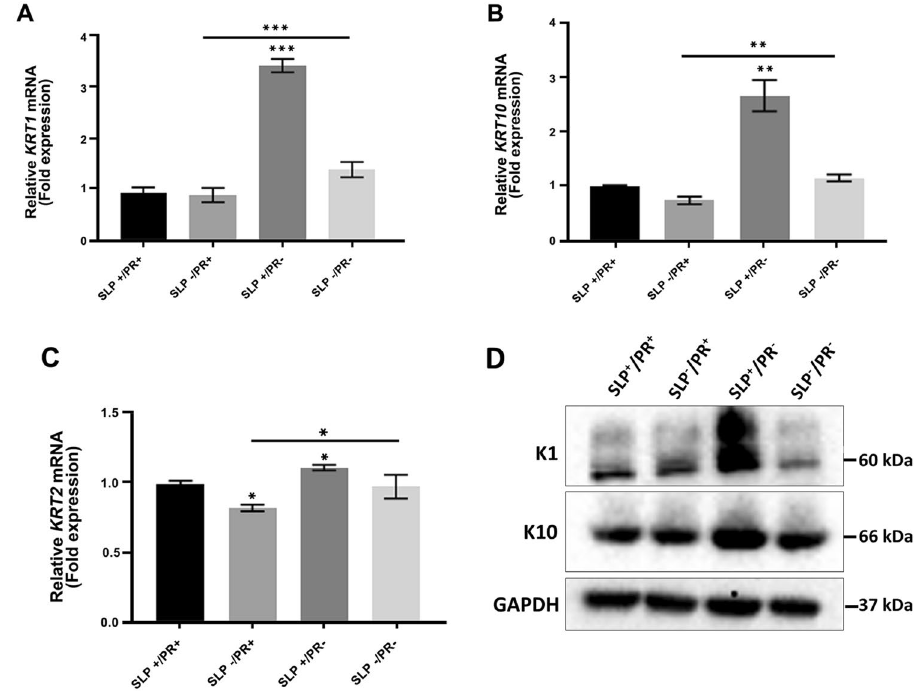
Figure 4. Influence of SLP and PR on mRNA and protein expression of K1, K10 and K2 in N/TERT-1 cells. N/ TERT-1 (200,000 cells) were grown in 2 ml growth medium per well of a 12 well plate for 3 days in four different RM + media conditions (SLP + /PR + , SLP − /PR + SLP + /PR − , SLP − /PR − ) in triplicates for each growth condition. Lysates were collected and analysed for mRNA using qPCR. The mRNA expression data are shown for ( A ) KRT1 , ( B ) KRT10 and ( C ) KRT2 as fold expression normalised to the expression of two housekeeping genes, POLR2A and YAP1 under different growth conditions. ( D ) N/TERT-1 (500,000 cells) were grown in 4 ml growth medium per well of a 6 well plate for 3 days in the above four different RM + media conditions in triplicates for each growth condition. SDS cell lysate containing 20 µ g total protein (measured by Lowry’s method using BSA as standard) was analysed by western blotting for K1 and K10 proteins under different growth conditions. GAPDH was used as a loading control. Relevant bands were cropped from different blots and grouped together. Original blots are shown in Supplementary Fig. S3. Statistical analyses: n = 3, Error bars = SEM, Student’s t-test was performed to calculate p values using Microsoft Excel. One-way ANOVA (shown by a horizontal line over each graph) was used to determine the statistical significance in gene expression between different growth conditions. The p values are given by asterisks ( * p < 0.05, ** p < 0.01, and *** p <